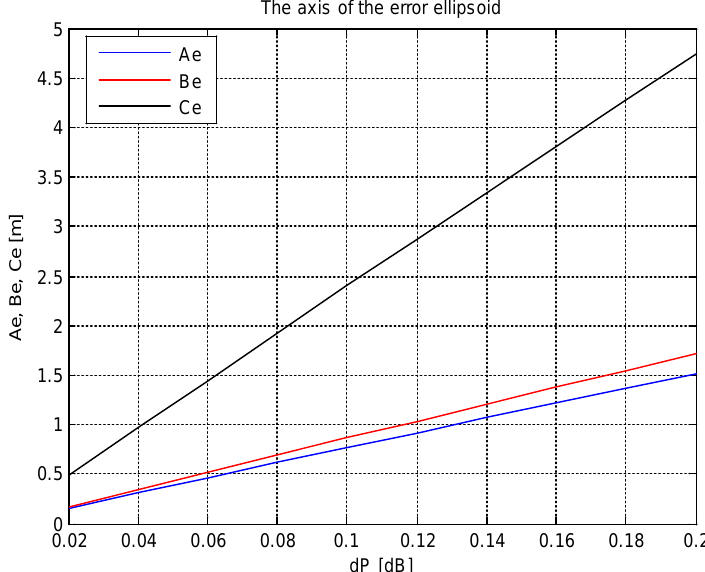
Figure 7. The lengths of axes of the error ellipsoid depending on the standard deviation of the power measurement.